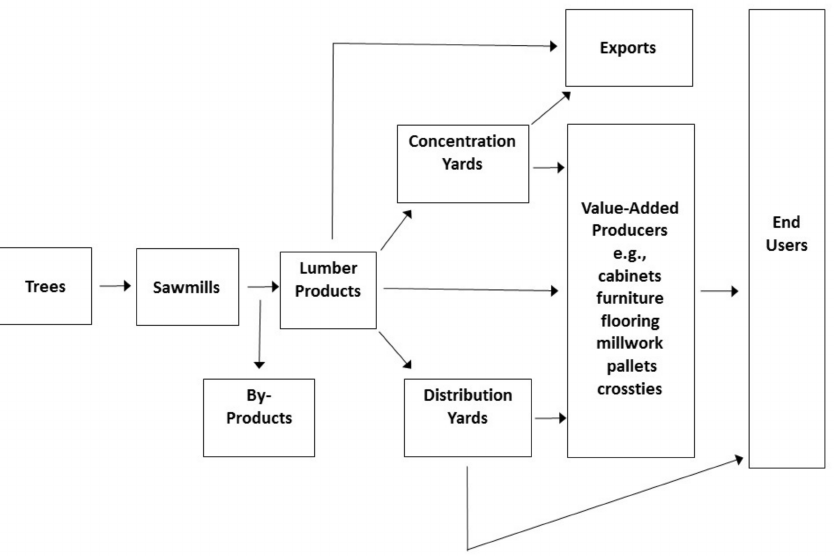
Figure 2. Basic value chain for North American hardwood product manufacturing (adapted from Cohen and Kozak